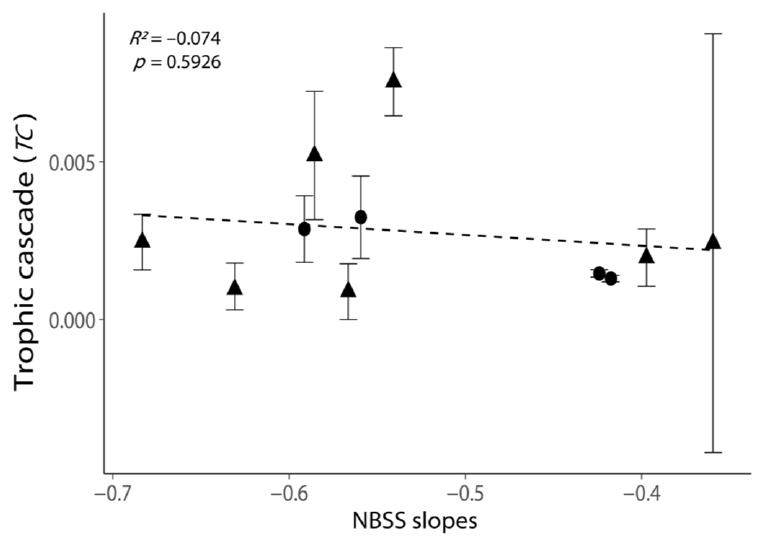
Figure 4. Relationship between the intensities of trophic cascades ( TC ) and the NBSS slopes. All values are shown as the mean ± 1 standard error. Negative values of TC were removed, as these experiments exhibited no trophic cascade. Triangular points indicate the TC calculated from the incubations with phytoplankton growth (Figure S2). The dash line indicates the best-fit regression line.